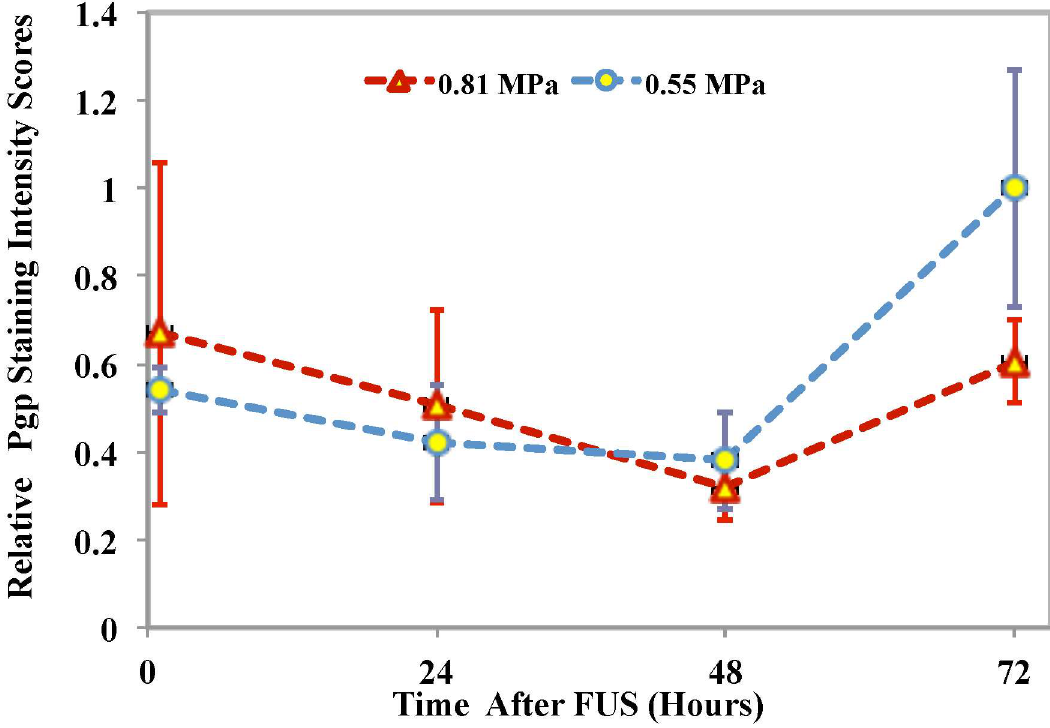
Fig 6. Relative Pgp staining intensity scores for the two exposure levels as a function of time. The scores were normalized to that measuredin the control hemisphere.The difference in the relative intensity scores were not significant (p = 0.25, 0.3, 0.24 and 0.058, for one, 24, 48 and 72 hours,